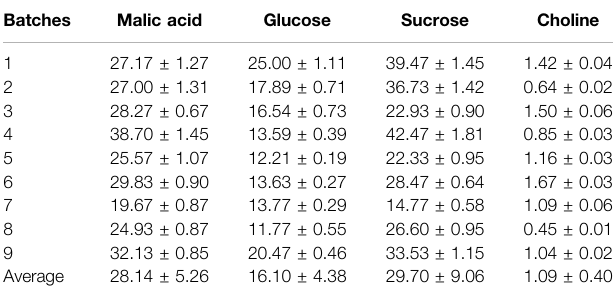
TABLE 2 | Contents(mg/g) offour primary metabolites innine batches of Coptidis Rhizoma extract (Mean ± SD, n (cid:2) 3). Batches Malic acid Glucose Sucrose